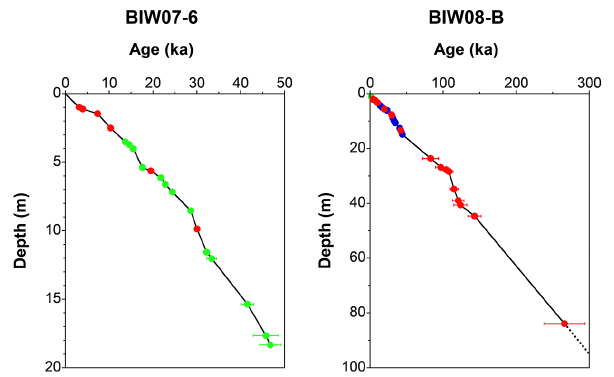
Figure 3. Age–depth models of cores BIW07-6 and BIW08-B. The red, green, and blue dots indicate volcanic ashes, 14 C of plant debris and total organic carbon, and ARM events, respectively (see Tables 1 and 2). Error bars indicate the 95% confidence intervals (2 σ)